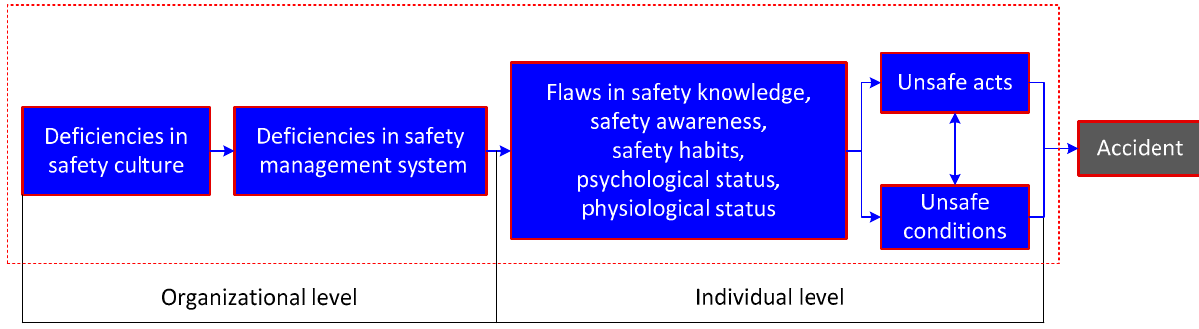
Figure 1. The accident causation model–24Mode l [34,36–39].